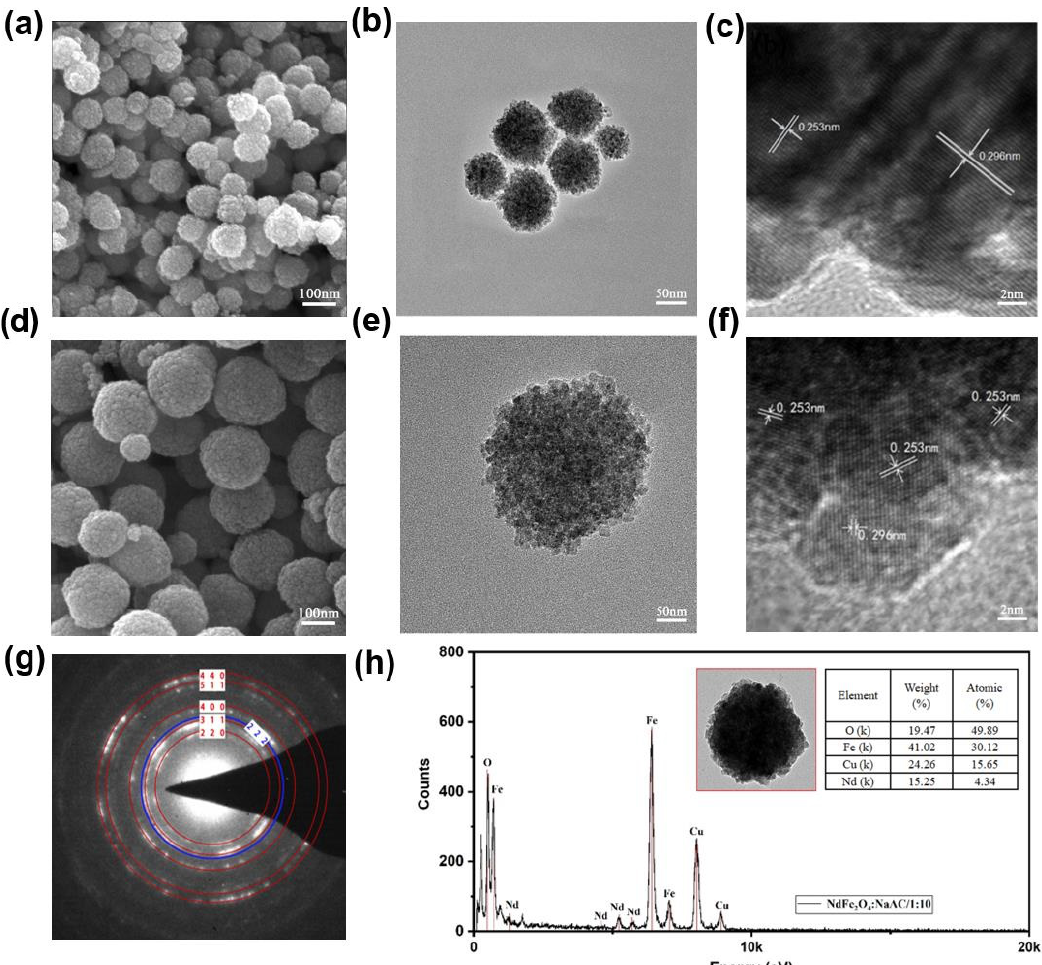
Figure 4. Characterization of NdFe 2 O 4 NPs. ( a ) SEM image, ( b ) TEM image, and ( c ) HR−TEM image of NdFe 2 O 4 NPs at 1:6 NaAC; (d) SEM image, ( e ) TEM image, ( f ) HR−TEM image, ( g ) electron diffraction, and ( h ) EDS pattern of NdFe 2 O 4 NPs at 1:10 NaAC.